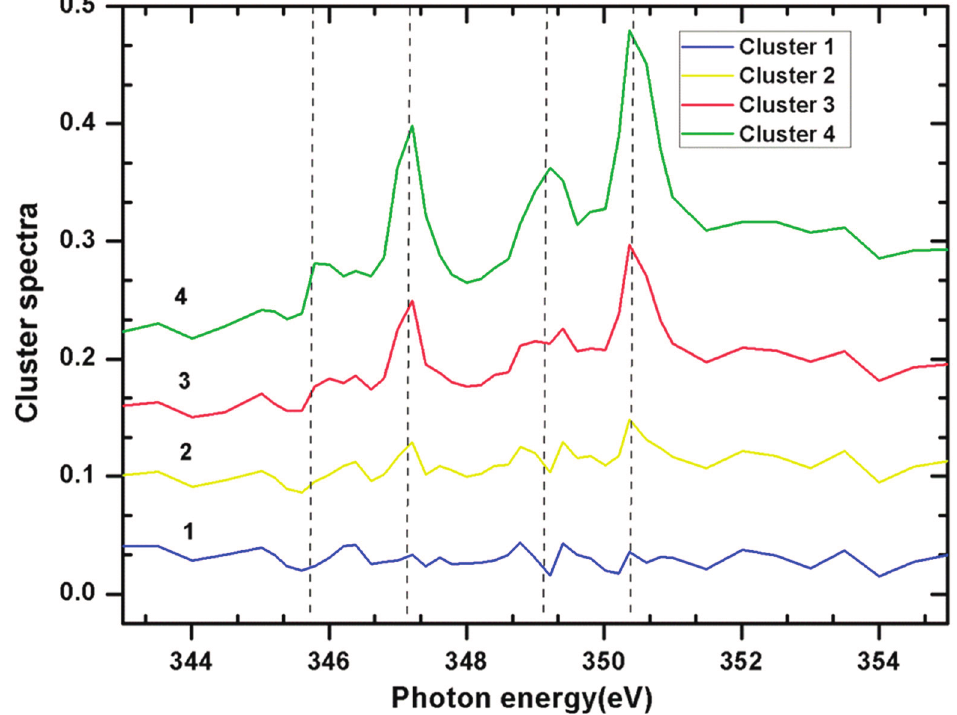
Figure 4. NEXAFS spectra of Ca L 2,3 edge of total Ca in E. huxleyi by cluster measurements